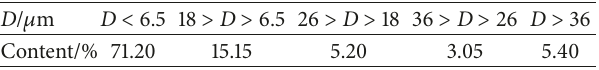
Table 3: Particle sizes of slow-settling